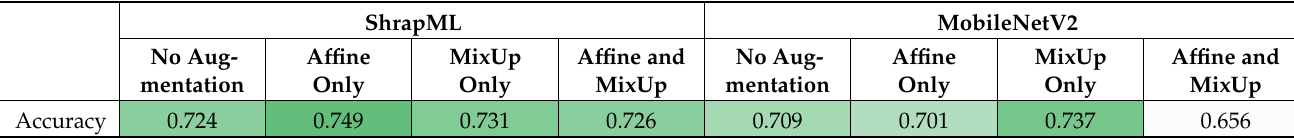
Figure 6. Data augmentation effects on blind test performance with a MobileNetV2 model architechture. Average confusion matrix results are shown for ( A ) no augmentation, ( B ) affine augmentation only, ( C ) MixUp augmentation only, ( D ) both affine and MixUp augmentations. Results are averaged for three training replicates for the five LOSO holdout runs. A total of 70 shrapnel and 70 baseline images were used for each blind test run. Table 2. Summary of performance metrics for different data augmentation strategies with ShrapML and MobileNetV2 models. Average results across three training replicates for each of five LOSO holdout runs are shown. Heat map overlay is set between the minimum and maximum value for each performance